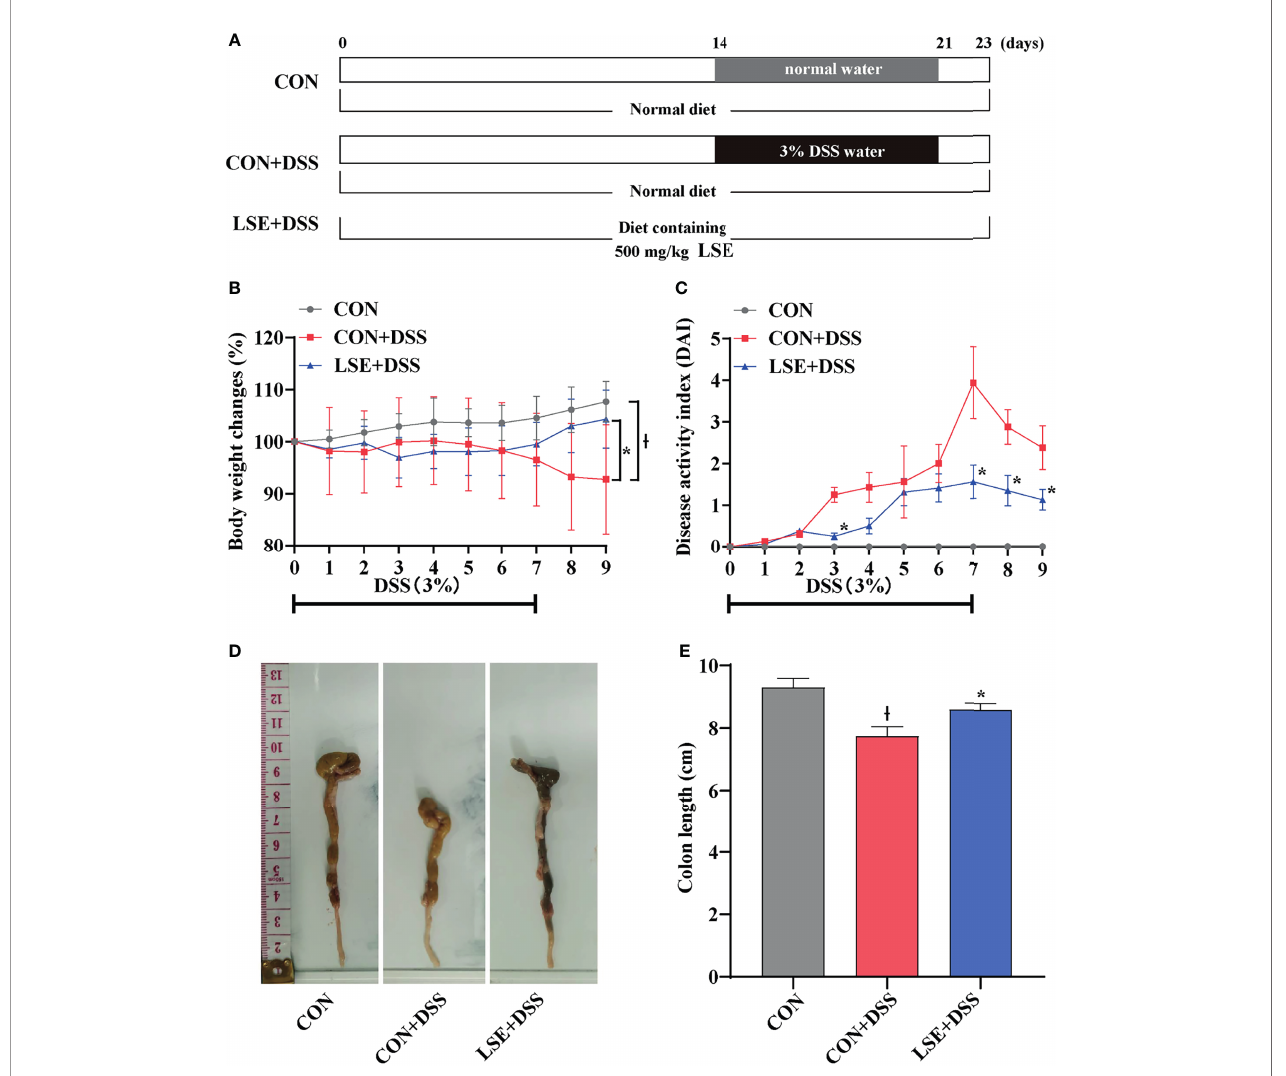
FIGURE 1 | Experimental schedule and basic indicators of LSE on DSS-induced colitis mice. (A) Animal treatment schedule. (B) Body weight changes. (C) DAI score during experimental colitis. * P < 0.05 vs. the DSS-treated group on the same day. (D) Images of the colon length. (E) Colon length in different treatment groups. * P < 0.05 vs. the CON+DSS group, Ɨ P < 0.05 vs. the CON group. Data are presented as mean ± SEM (n = 16 per group). CON (Control group); DSS (Dextran Sulfate Sodium Salt); CON+DSS (CON+DSS group); LSE+DSS (LSE+DSS group). LSE represents extracts from Lonicera hypoglauca and Scutellaria baicalensis . The same as